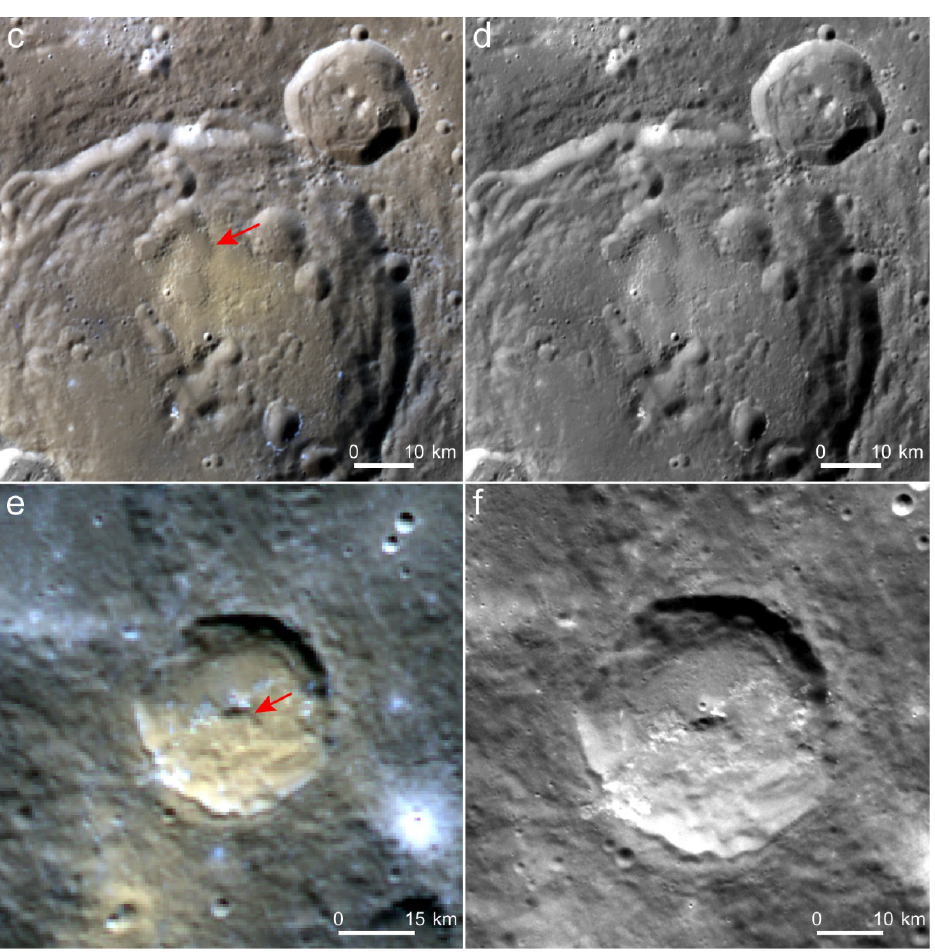
Figure 3. Other candidates of pitted-ground terrains that need higher-resolution images to confirm their identity. The first column shows color mosaics, and the second column shows monochrome mosaics for the three examples. ( a , b ) A possible pitted-ground terrain that is developed in an older volcanic pit (red arrow) judged by the preservation states (central coordinates are 60.8 ◦ S, 168.1 ◦ E). ( c , d ) A possible pitted-ground terrain that is developed in an older volcanic pit (red arrow) centered at 43.37 ◦ N, 82.67 ◦ E. ( e , f ) A possible pitted-ground terrain among the Bitin Facula (red arrow). IDs of the base data used are listed in Table